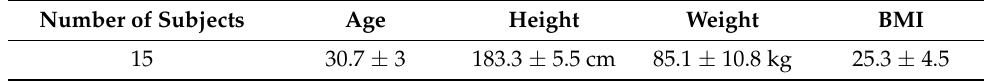
Table 1. Subject’s characteristics (mean ± standard